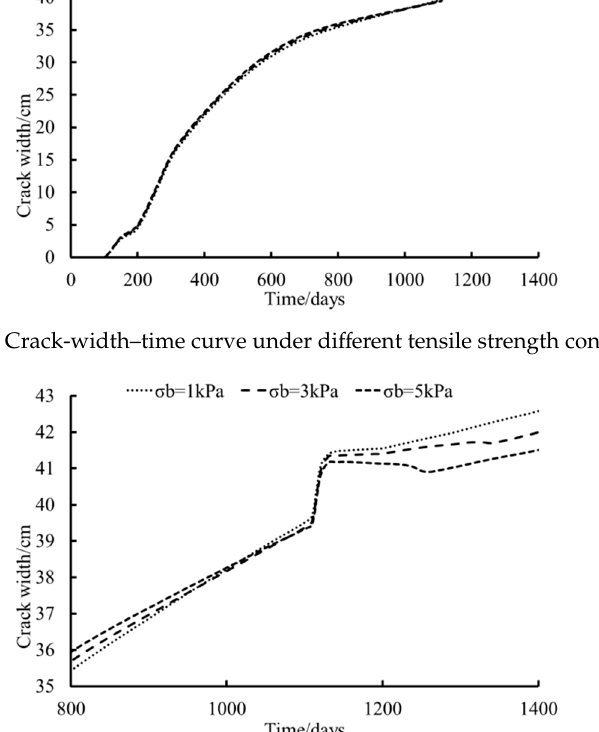
Figure 20. Crack-width–time curve under different tensile strength conditions after 800 days.